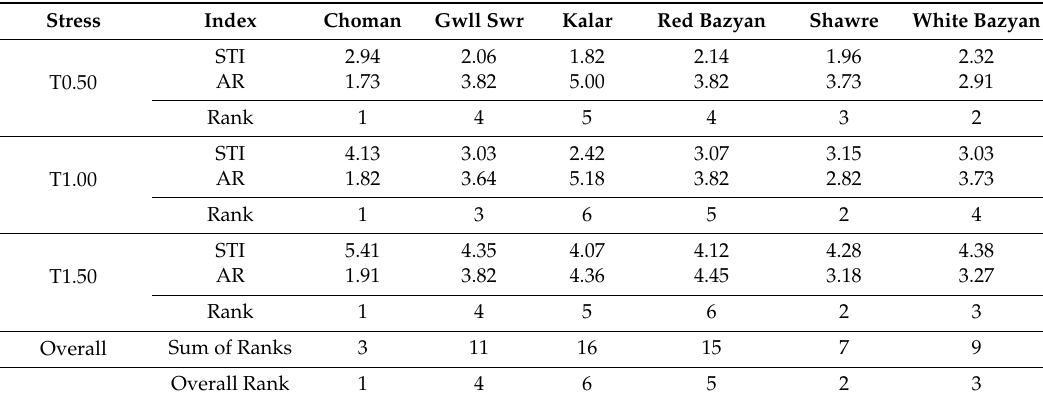
Table 8. Rank of rice genotypes determined by the stress tolerance index (STI) and the average number of ranks (ASRs) dependent on biochemical characteristics under stress conditions. Genotypes with the highest STI and lowest ASR values were considered to be the best genotypes and the lowest rank was given to the best performance of each